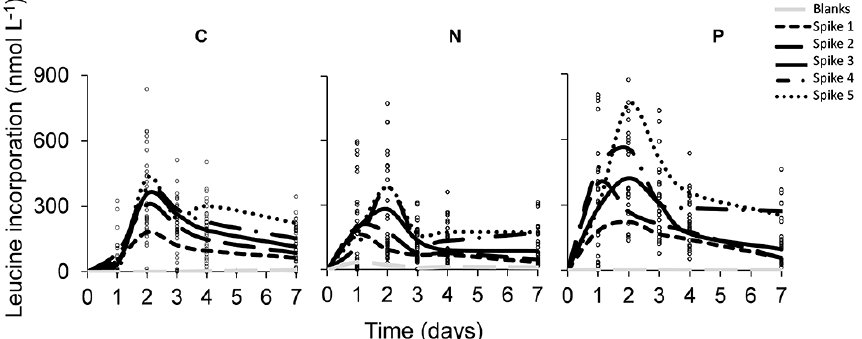
Figure 1. Leucine incorporation rates over the incubation time for a blank incubation and five spikes of C (spike 1 = 330, spike 2 = 660, spike 3 = 1000, spike 4 = 1330, and spike 5 = 1500 µg C L − 1 ) , N (spike 1 = 105, spike 2 = 133, spike 3 = 205, spike 4 = 305 and spike 5 = 405µgNL − 1 ) and P (blank, spike 1 = 15 . 5, spike 2 = 18 . 8, spike 3 = 20 . 5, spike 4 = 30 . 5, and spike 5 = 40 . 5µgPL − 1